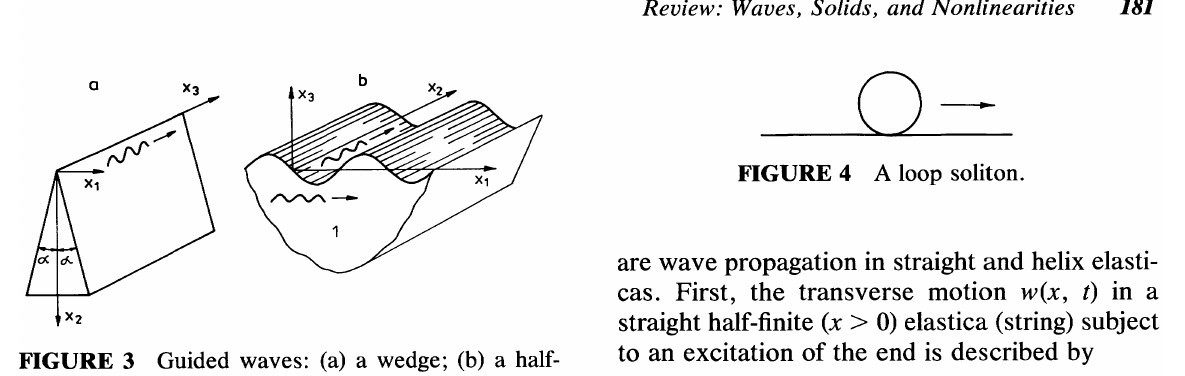
FIGURE 3 Guided waves: (a) a wedge; (b) a half space with corrugated surface.